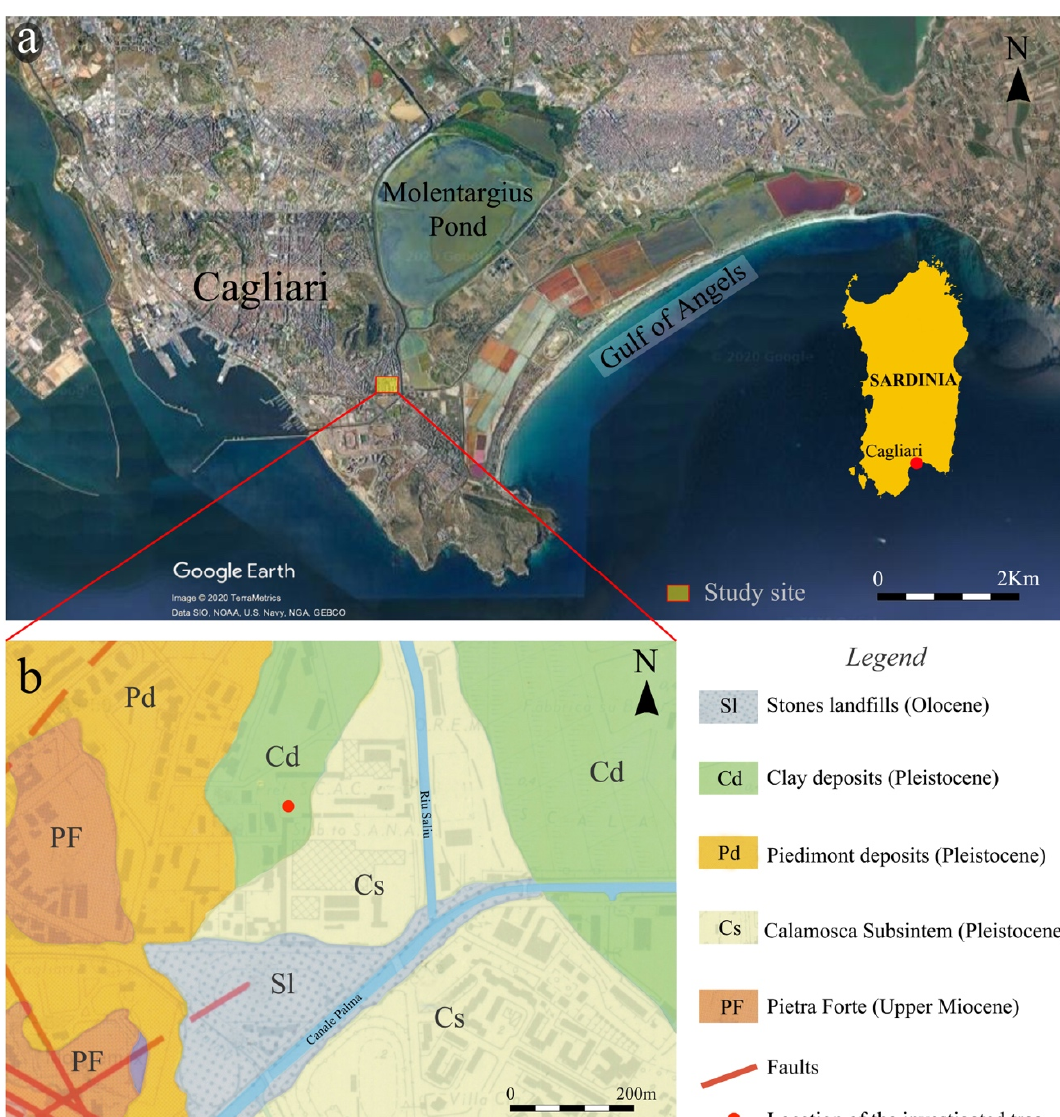
Figure 1. ( a ) Geographical position of the investigated holm oak (39°12’25.5” N–9°08’28.4” E, modified from Google Maps, Map data: Google, Maxar Technologies); ( b ) Geological setting of the study site. Modified from Barrocu et al., 1981 [33].